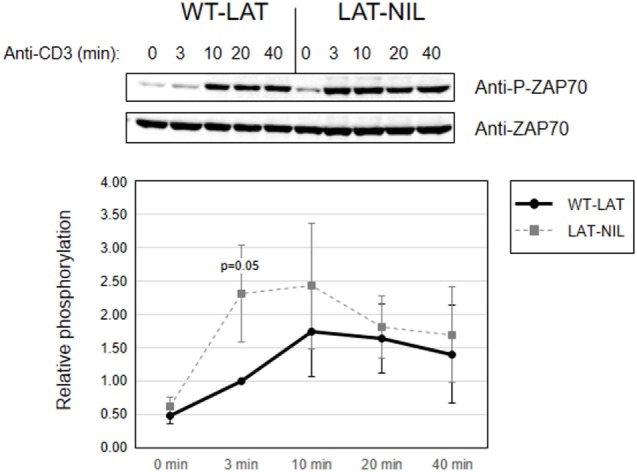
ZAP70 activation is increased in linker for activation of T cell (LAT)-NIL expressing cells. Phosphorylation of ZAP70 in WT-LAT or LAT-NIL expressing cells stimulated with soluble anti-CD3 was detected by Western blot using antibodies against pY319-ZAP70 (upper panel) and total ZAP70 (lower panel). The lower diagram represents the quantification of six independent experiments using J.CaM2 cells expressing WT-LAT (thick continuous line) or the LAT-NIL mutant (thin dashed line). Phosphorylation levels were normalized to total ZAP70 expression and the means of fold increase of phosphorylation with regard to non-stimulated cells were graphed. Bars represent the standard error.